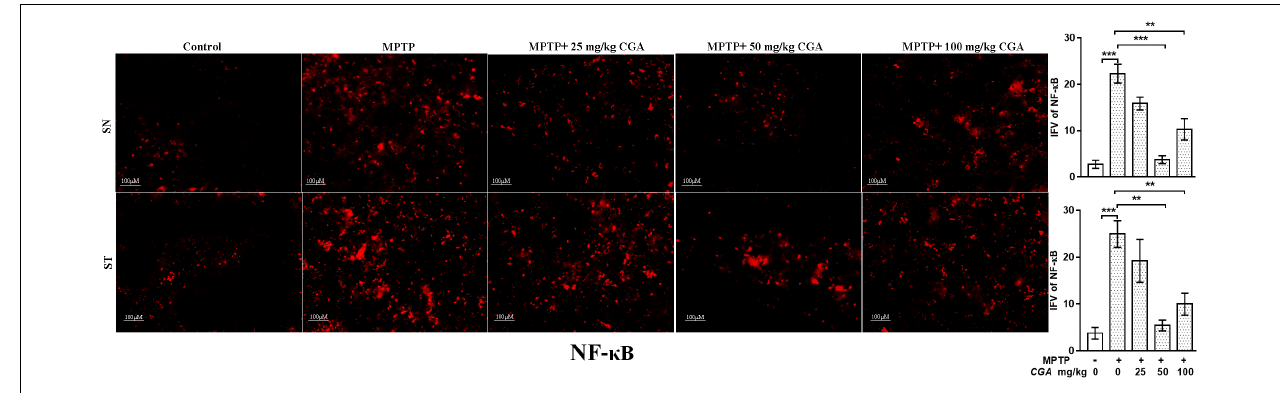
FIGURE 9 | IHC of NF- κ B in SN and striatum of mice. With 20 × magnifications after staining. NF- κ B shows profound expression in the SN and striatum of MPTP-treated mice compared with the control group mice, while CGA treatment in MPTP mice shows moderate staining of NF- κ B. Values are expressed as mean ± SEM ( n = 3). ∗ p < 0.05, ∗∗ p < 0.01, and ∗∗∗ p < 0.001. CGA, chlorogenic acid; MPTP, 1-methyl-4-phenyl-1,2,3,6-tetrahydropyridine; SN, substantia nigra; ST, striatum; NF- κ B, Nuclear factor κ B; SEM, standard error of mean; IFV, integrated fluorescent value.